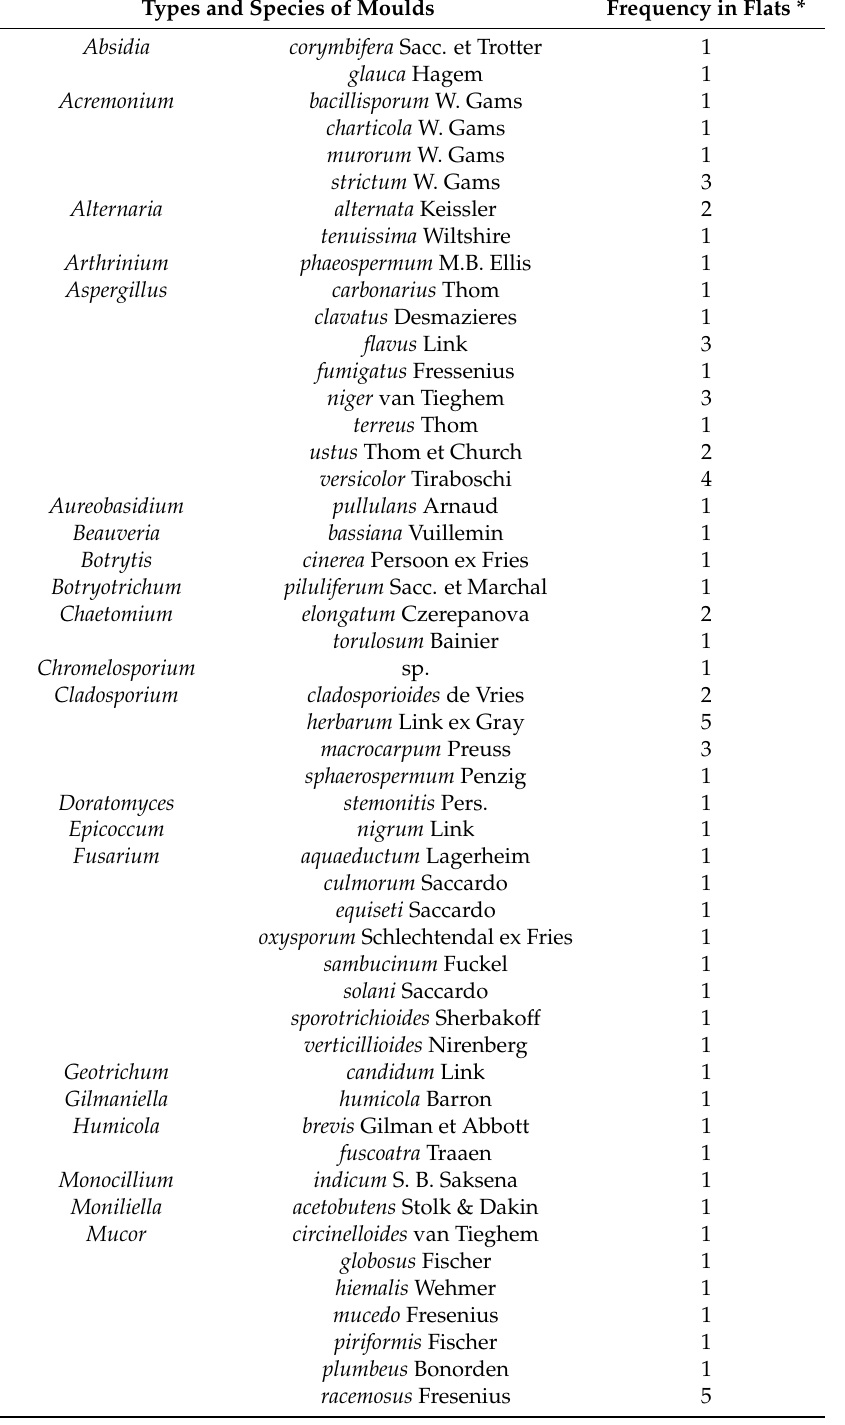
Table 3. Species of moulds isolated from building partitions in the area of the Lubuskie